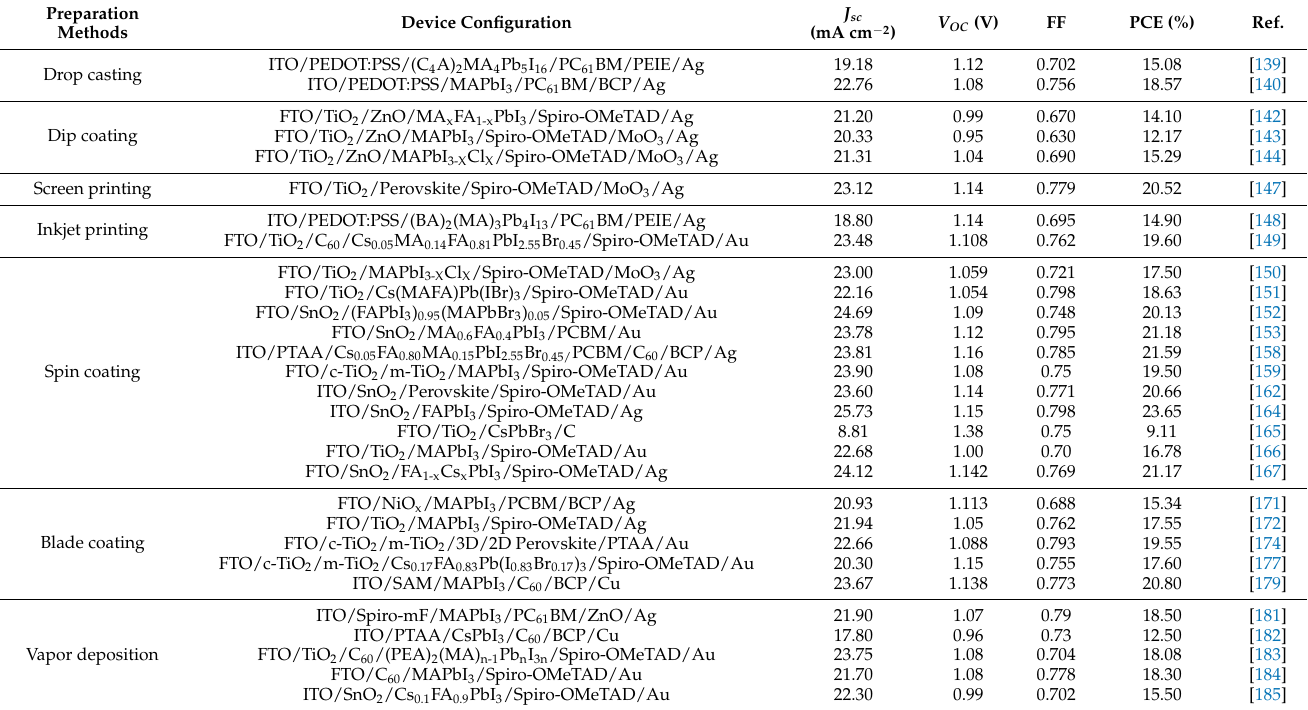
Table 2. Summary of various PSC performances using various preparation